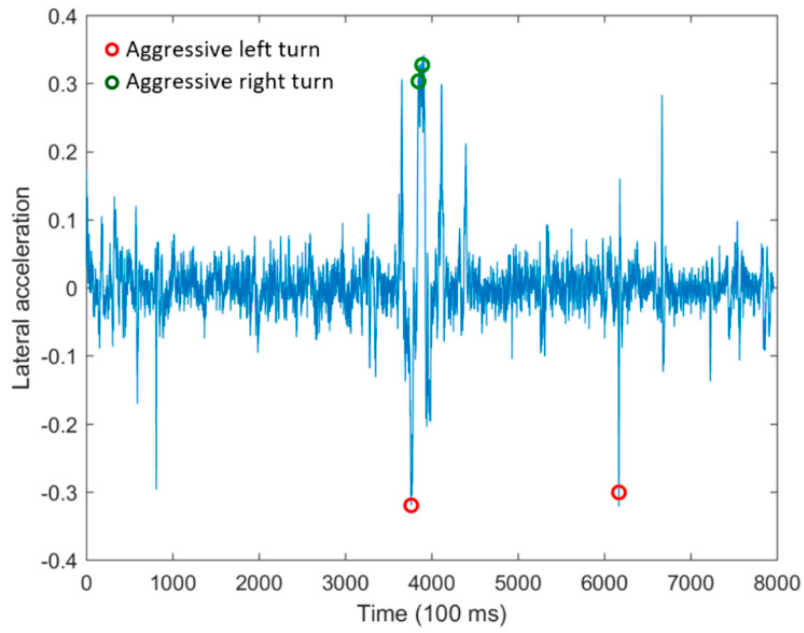
Figure 7. Situations when aggressive left and right turns are recognized.